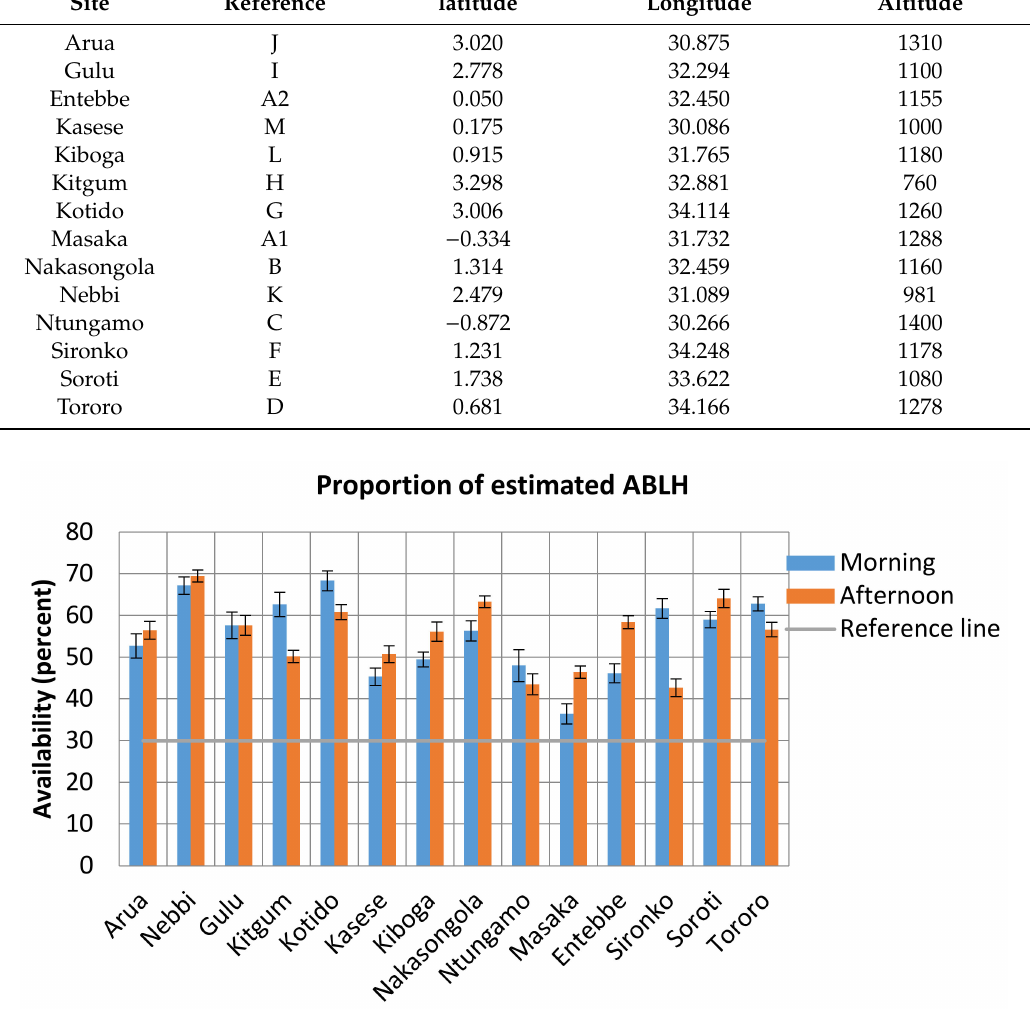
Table A1. Points of reference for the retrieval of MODIS atmospheric profiles. Letters are adopted from Figure 1.